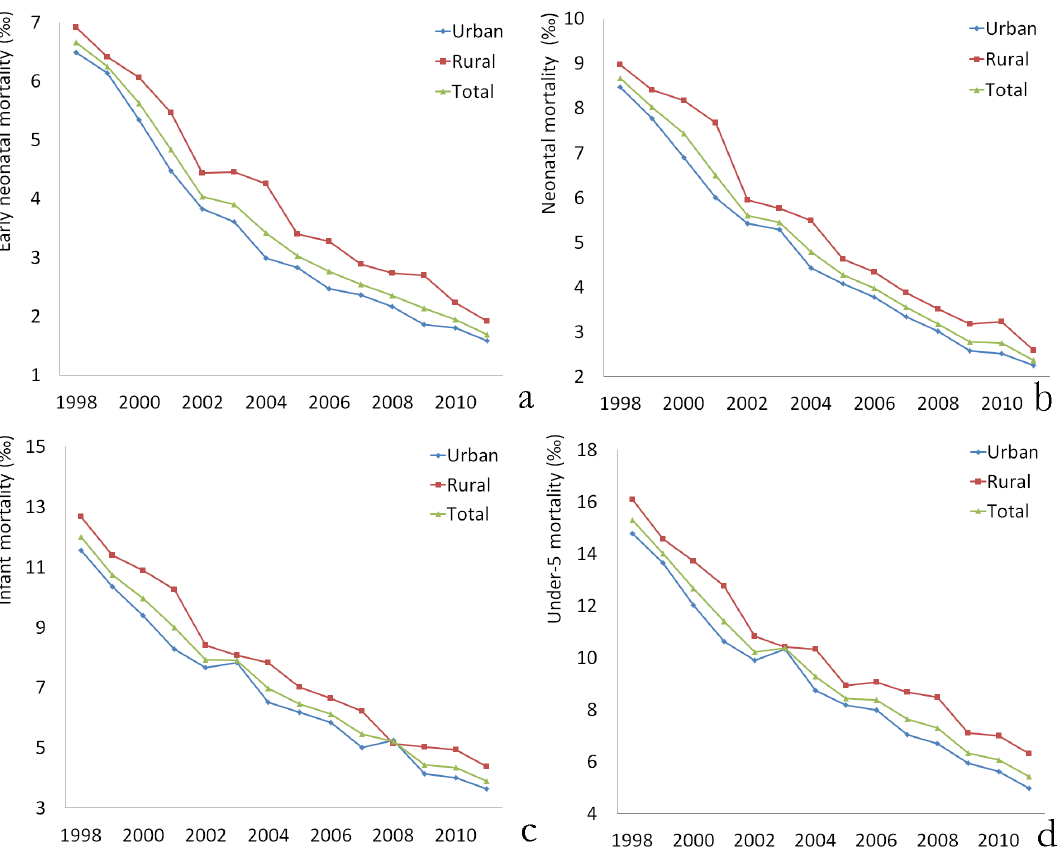
Figure 3. Mortality rates between 1998 and 2011. (a) Early neonatal mortality; (b) Neonatal mortality; (c) Infant mortality; (d) Under-5 mortality.